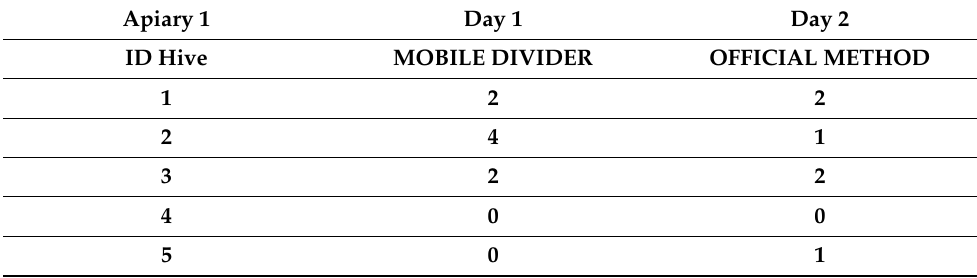
Table 3. Number of detected A. tumida in apiary 1 with the two different methods on day 1 and day